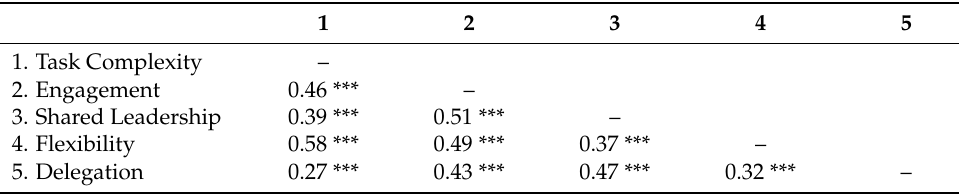
Table 2. Association between variables under